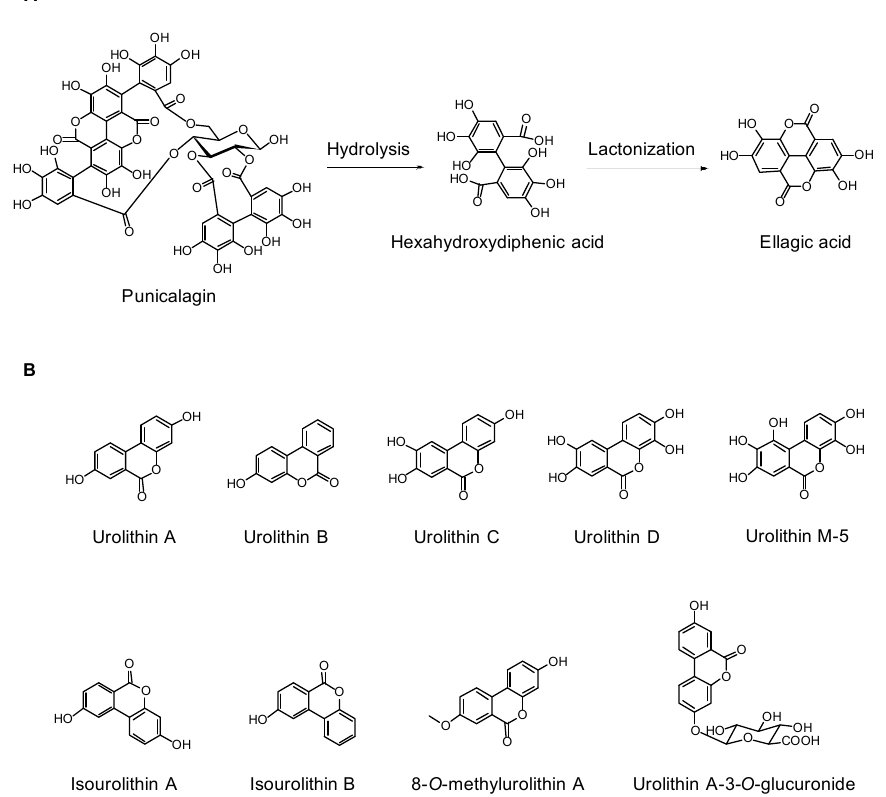
Figure 1. Pomegranate ellagitannin-derived metabolites. ( A ) Punicalagin (a pomegranate ellagitannin) is hydrolyzed to hexahydroxydiphenic acid, which is lactonized to yield ellagic acid; ( B ) Chemical structures of representative urolithins, the microfloral transformation products of ellagic acid.